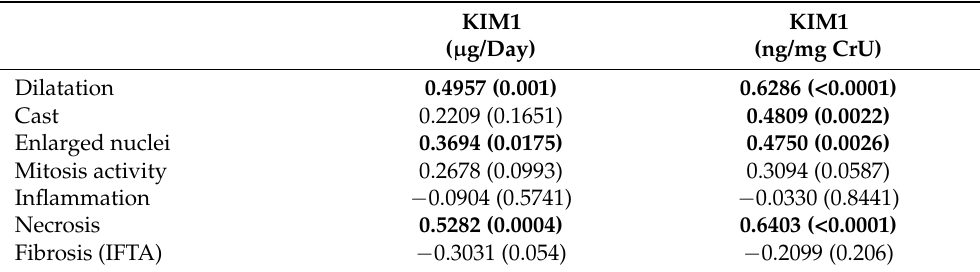
Table 1. Spearman’s correlation between urinary levels of KIM-1 in recuperation points (R0–R4) and the degree of histological renal damage parameters. In bold, statistically significant differences. p -value in parentheses.